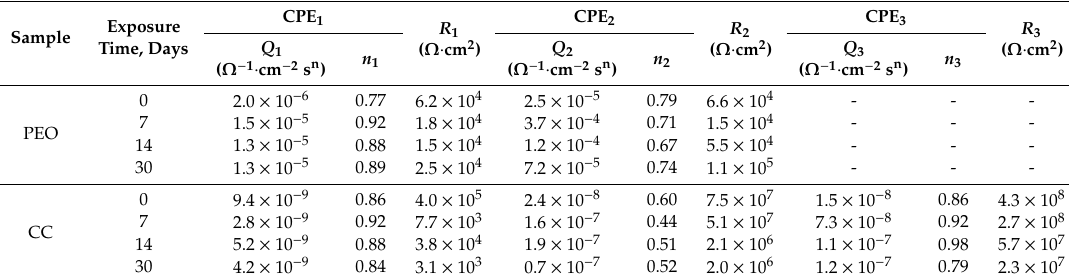
Figure 19. Bode plots obtained in 3% NaCl for PEO ( a , b ) and composite coatings ( c , d ) before and after 7, 14 and 30 days of marine immersion. Table 11. PEO and composite coatings EEC parameters before and after 7, 14 and 30 days of marine immersion (Figure